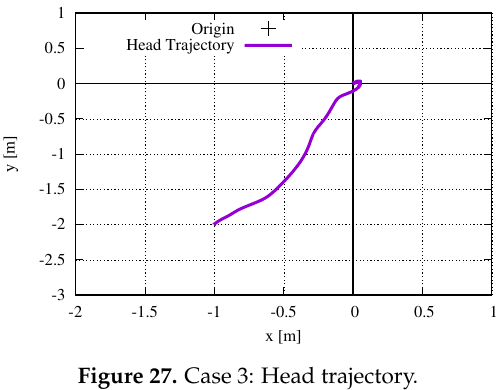
Figure 27. Case 3: Head trajectory.